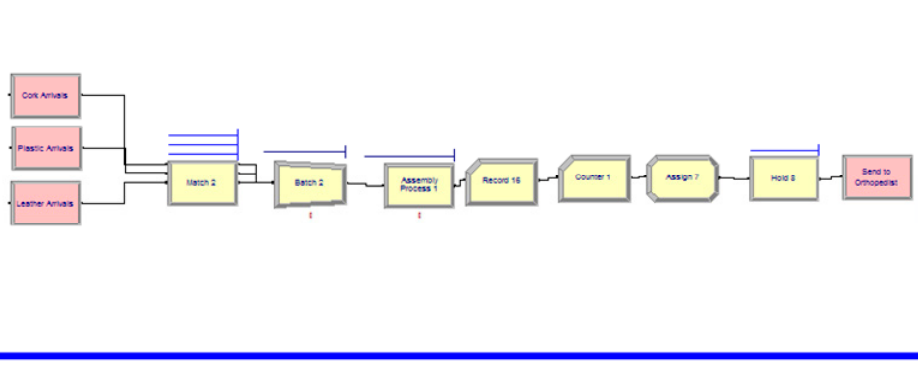
Figure 8. Shipping cork, plastic and leather from suppliers to the two manufacturers. Logistics 2018 , 2 , 13